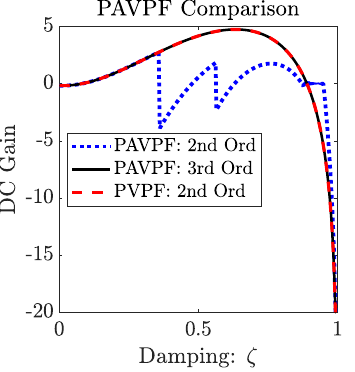
Figure 7. This figure details the comparison of PVPF (red dashed) and PAVPF (blue dotted) designed on the second–order system compared with PAVPF (black solid) designed on the third–order system in order to force proper conditioning of